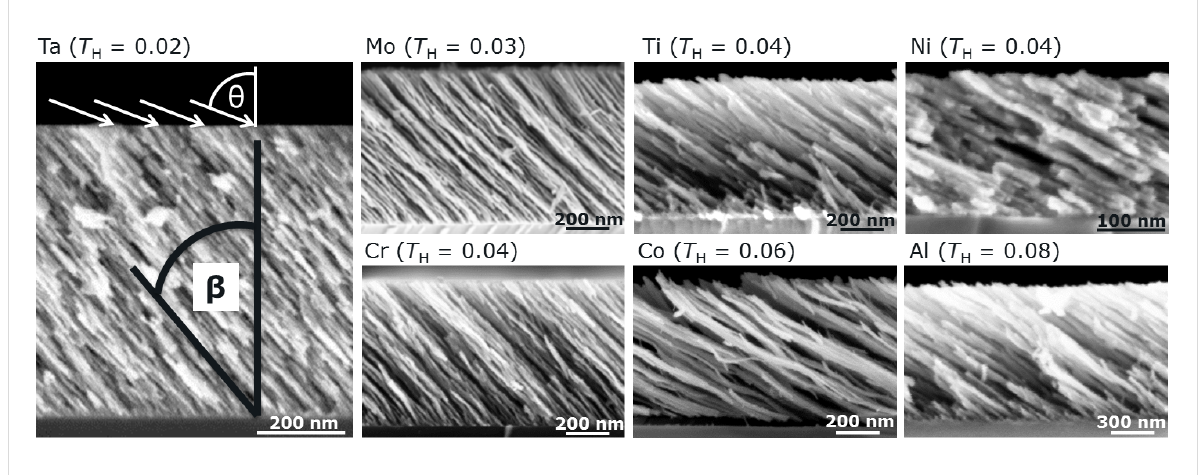
Figure 4: Cross-sectional SEM images of tilted metallic columns deposited at an incidence angle of 82° on thermally oxidized Si substrates and at a substrate temperature of 77 K. The tilt angle of the columns is β and θ depicts the incidence angle, both with respect to the substrate normal. T H is the homologous temperature.